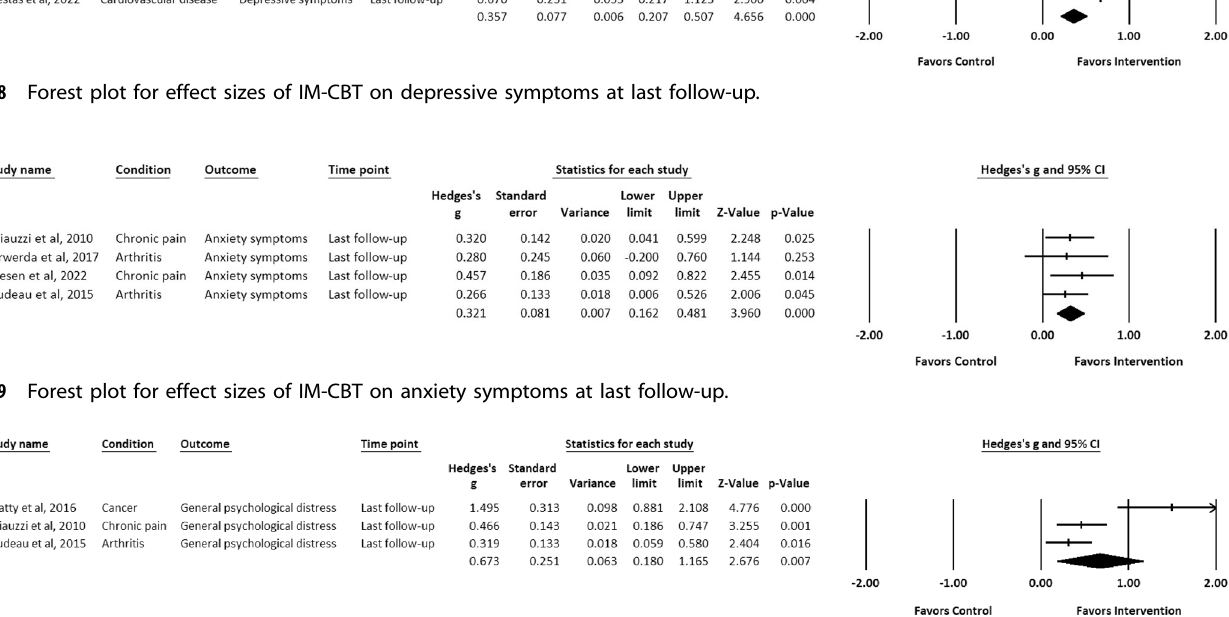
Fig. 10 Forest plot for effect sizes of IM-CBT on general psychological distress at last follow-up.